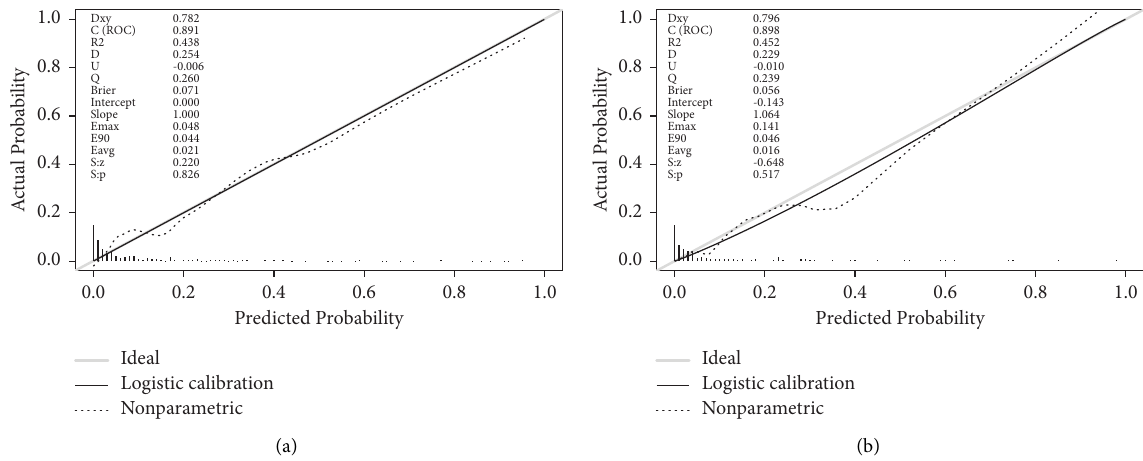
Figure 4: Calibration plots of the nomogram in the training cohort (a) and validation cohort (b). In both groups, although the apparent and corrected curves deviated slightly from the reference line, they also showed good agreement between observation and prediction.